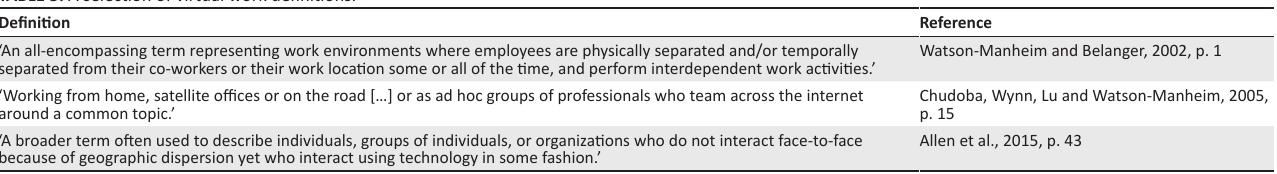
TABLE 3: A selection of virtual work definitions. Definition